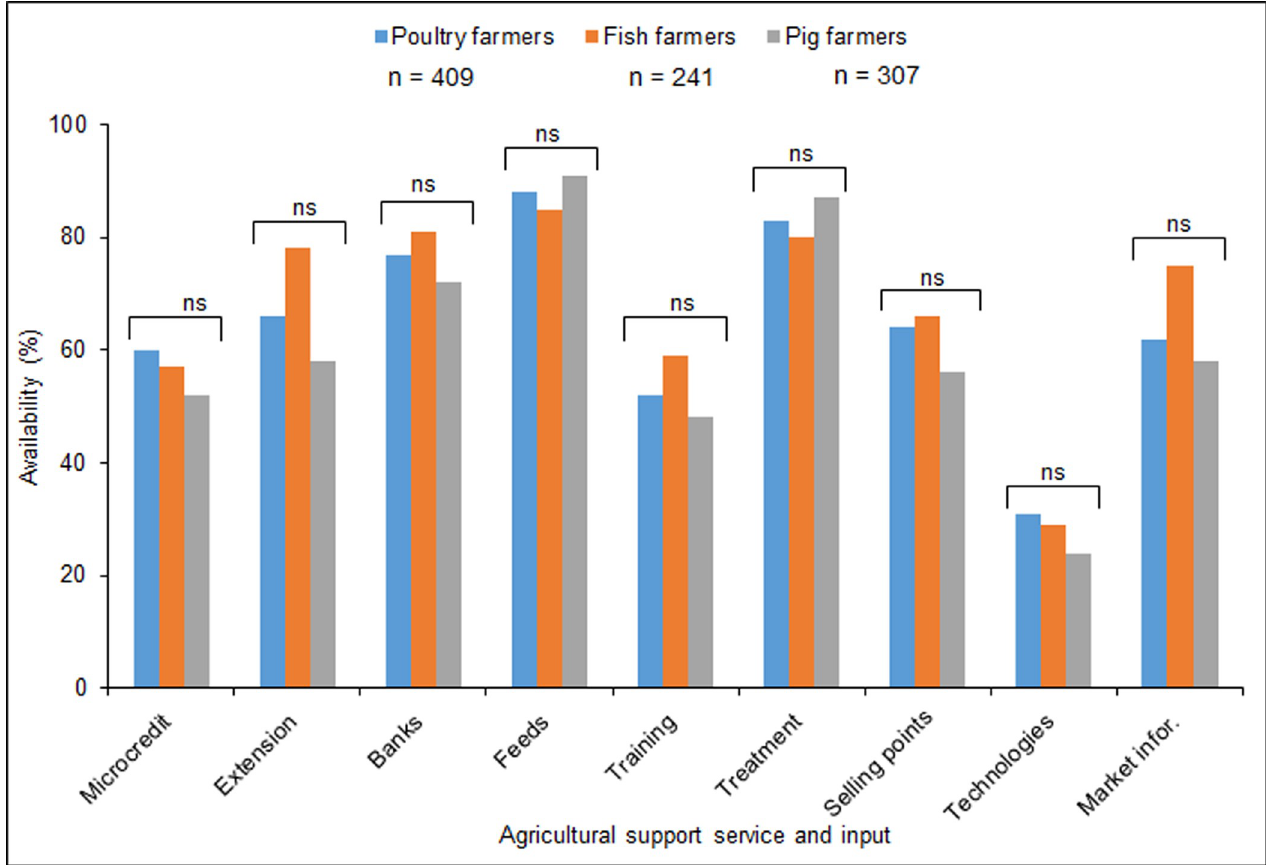
Fig 3. Percentage availability of agricultural support services and inputs to poultry, fish and pig farmers. Bars with “ns” are not significantly different, P < 0.05, Chi-squared test. Microcredit = availability of savings and credit cooperatives that provide saving and credit facilities at low interest rates; Extension = availability of agricultural extension services; Banks = availability of main stream banking services; Feeds = availability of commercial feeds and feed ingredients for the different livestock types; Training = availability of production education programs; Treatment = availability of vaccines and general disease control facilities; Selling points = selling points for poultry, fish and pig products; Technologies = availability of improved feeds, feeding, housing and general production methods; Market infor = availability of information regarding demand and supply of farm inputs and outputs.